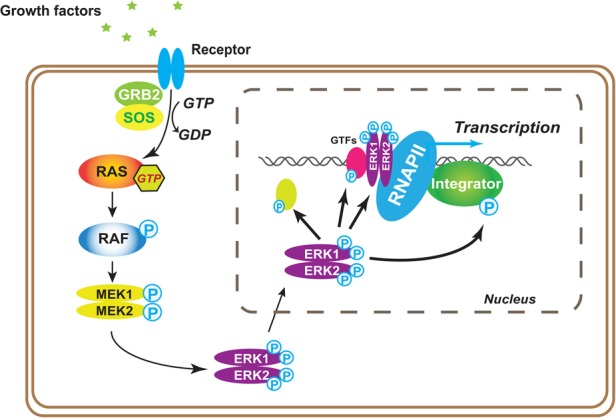
Model depicting Integrator's role as a critical node in MAPK transcriptional induction. Following growth factor stimulation, ERK1/2 are phosphorylated at Tyr204/187 and then Thr202/185 through the canonical RAS–RAF–MEK signaling cascade. The phosphorylation of both tyrosine and threonine enables the enzyme activation. Activated ERK1/2 translocate into the nucleus and regulate the IEG response through phosphorylating related nuclear transcription factors. Integrator is phosphorylated and recruited onto chromatin after the activation of MAPK signaling, which is required for growth factor-stimulated gene activation.